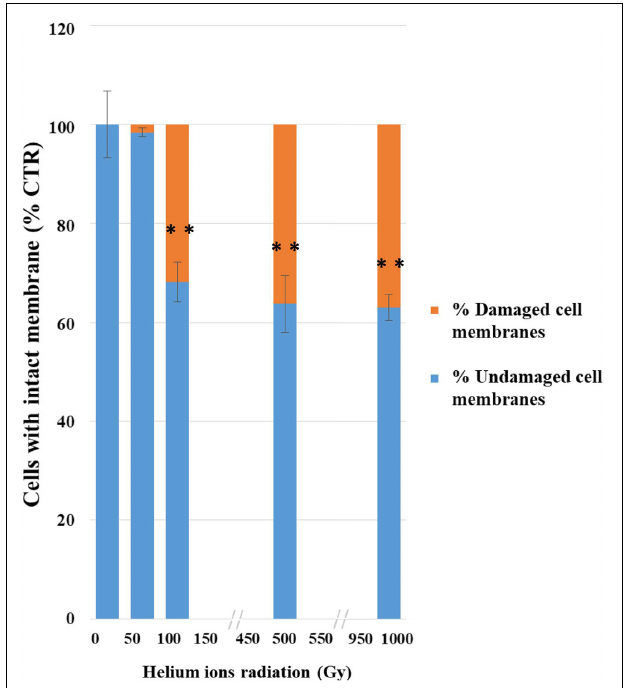
FIGURE 2 | Effects of irradiation on metabolic activity of C. antarcticus cells by XTT assay after helium ions radiation. O.D. 492 nm, optical density at 492 nm. Data were normalized with the control. Significant differences were calculated by Tukey test with ∗∗ p > 0.001.